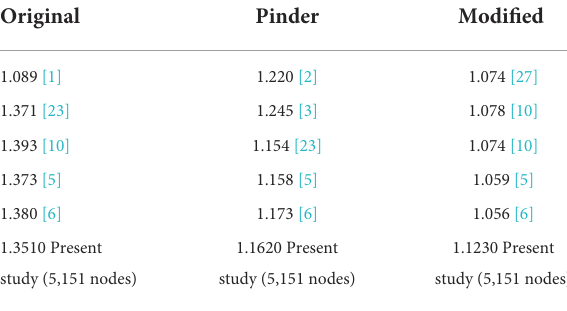
TABLE 2 Comparison of xToe position for the isochlor C =